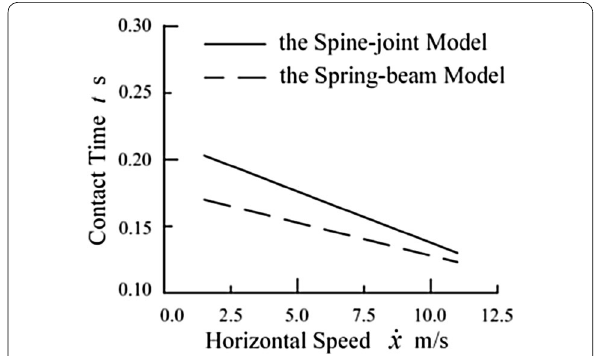
Figure 4 Trajectories of contact time along with horizontal